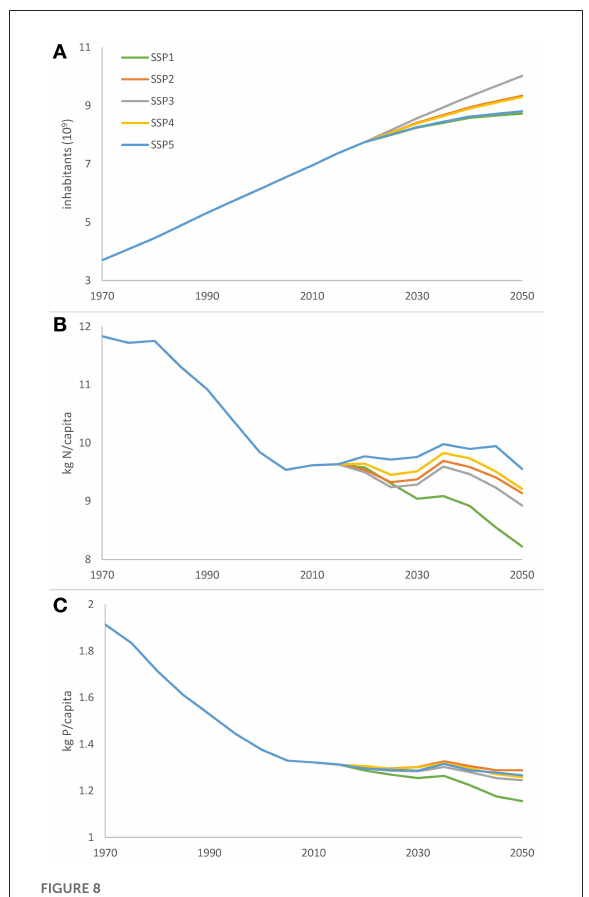
FIGURE8 (A) Global total population and (B) the annual global total N delivery per capita and (C) annual global total P delivery per capita for the five SSPs for the time period